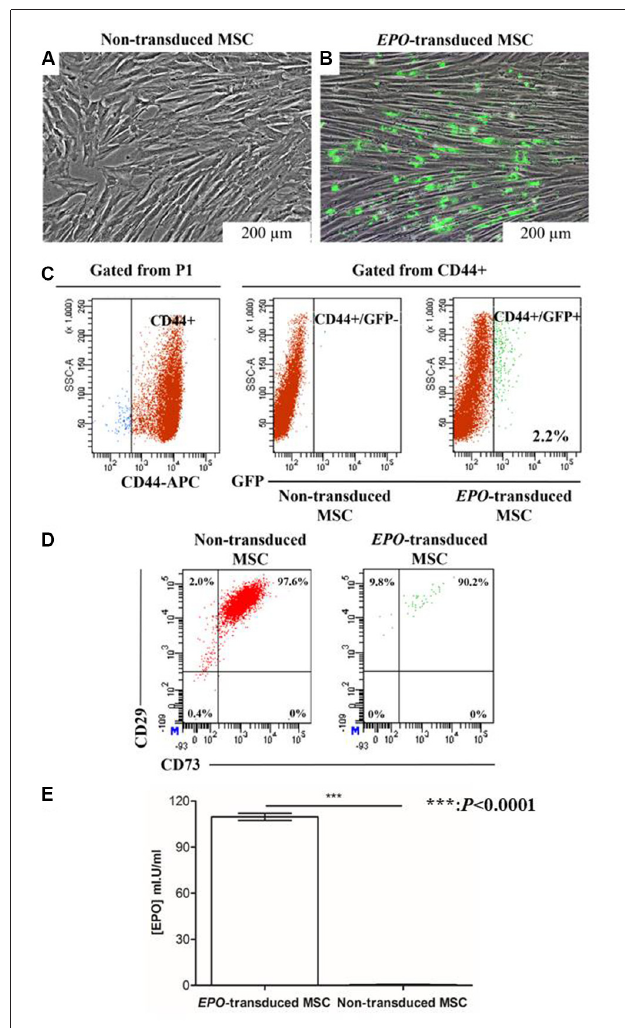
FIGURE 3 | Determination of transduction efficiency based on green fluorescent protein (GFP) expression and erythropoietin (EPO) concentration in the supernatant of transduced cells. (A) Fluorescence microscopy images of transduced cells 21 days after transduction, and (B) non-transduced cells. (C) Flow cytometry dot plots showing the transduction efficiency of GFP positive non-transduced (red) and EPO -transduced (green) MSCs. The percentage of GFP+ MSCs upon transduction was measured by flow cytometry. Numbers indicate the percentage of cells in each gate. Fluorescence intensity of EPO -transduced MSCs were gated from the P1 population of non-transduced MSCs and referred to as GFP+. Flow cytometry showed that gated cell populations from CD44+ were positive for GFP. (D) Flow cytometry dot plots showed that transduced cell populations from GFP+ cells were positive for CD73 and CD29. An isotype control was included in the experiment to identify background fluorescence (data not shown). (E) EPO concentration in the conditioned medium of transduced MSCs. EPO concentration was significantly increased in the conditioned medium collected from transduced MSCs compared with that collected from non-transduced MSCs. Data are reported as the mean ± standard error of the mean (SEM) of three independent experiments ( n = 8). ∗ P < 0.0001 respect to non-transduced MSCs by unpaired two-tailed Student’s t -test.